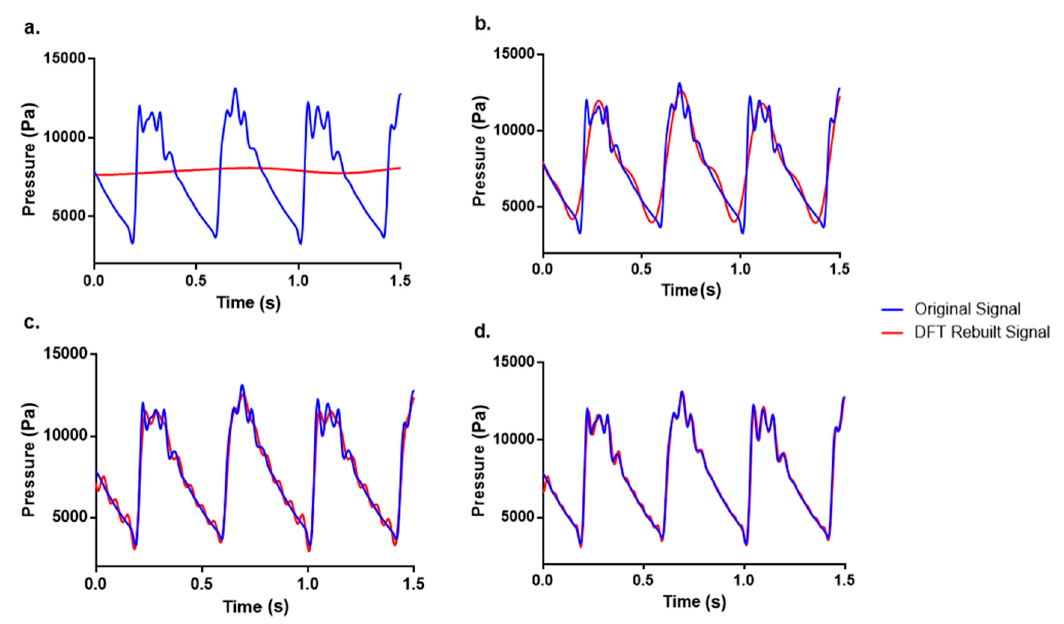
Figure 10. Comparison between the experimental Inlet pressure signal and the reconstructed DFT signal for ( a ) 10 harmonics, ( b ) 50 harmonics, ( c ) 150 harmonics, and ( d ) 200 harmonics.